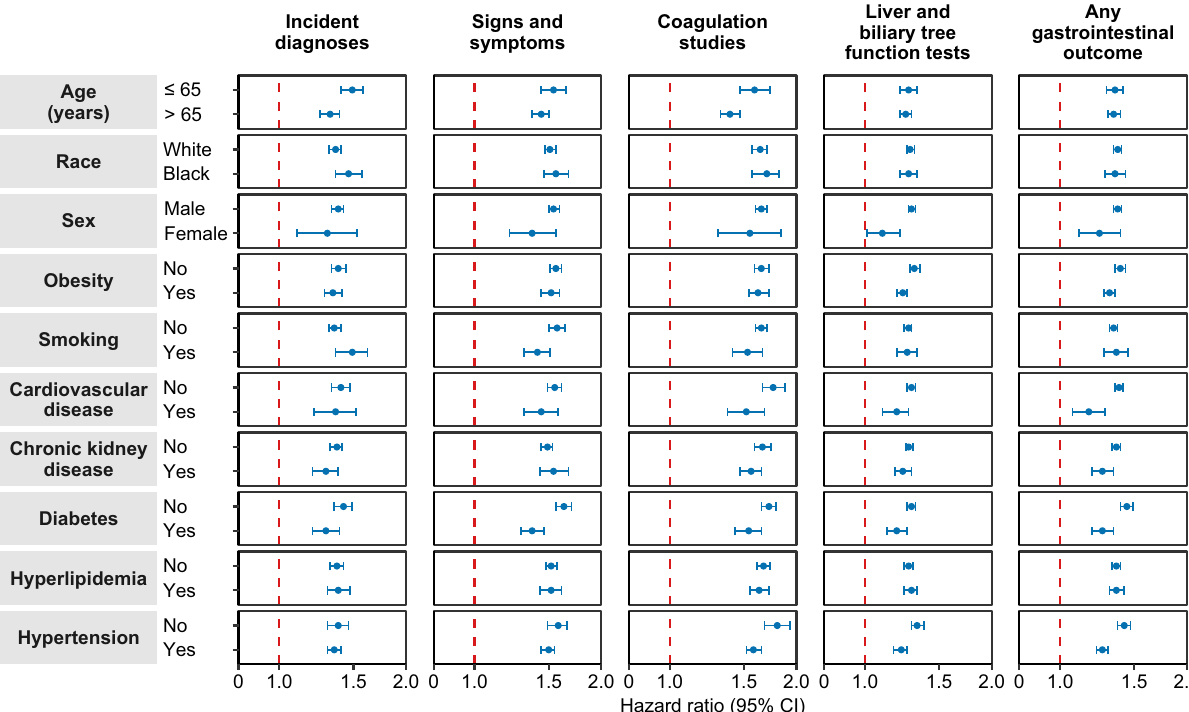
Fig. 3 | Subgroup analyses of the risks of incident post-acute COVID-19 com- posite gastrointestinal outcomes compared with the contemporary control cohort. Composite outcomes consisted of incident diagnoses (GERD, PUD, acute pancreatitis, functional dyspepsia, acute gastritis, IBS, and cholangitis), signs and symptoms (constipation, abdominal pain, diarrhea, vomiting, and bloating), coa- gulation studies (PT, PTT, INR), liver and biliary tree function tests (albumin, ALT, total protein, AST, LDH, CRP, ALP, total bilirubin, GGT, direct bilirubin, lipase, and amylase) and any gastrointestinal outcome (incident occurrence of any gastro- intestinal outcome studied). Outcomes were ascertained 30d after the COVID-19-